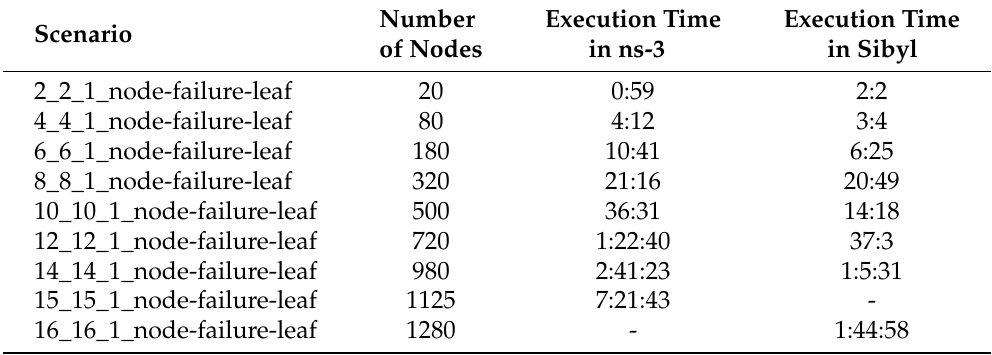
Table 3. Comparison of execution times between the environment in ns-3 and the sibyl framework for the failure of a leaf node in fat-trees